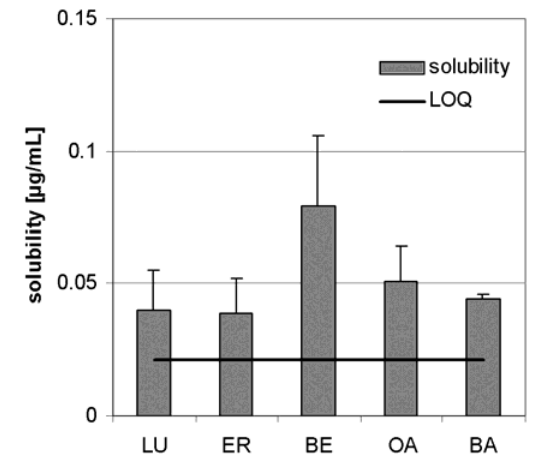
Figure 2 . Aqueous solubility of TE (n = 3, error bars: